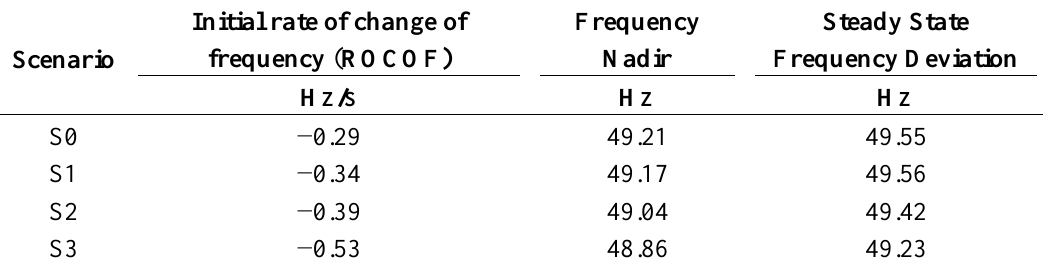
Table 2. Security Indices: PV-PPs without FFR capability.